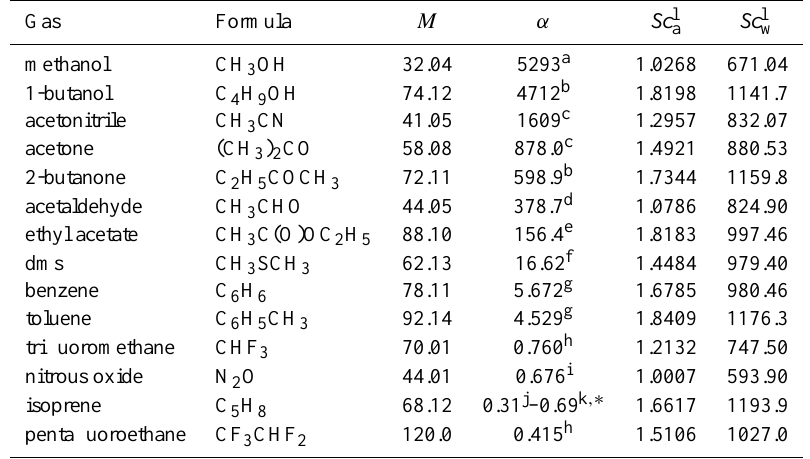
Table 1. Molecular masses ( M in gmol − 1 ), dimensionless solubility ( α ) and Schmidt numbers in air ( Sc a ) and water ( Sc w ) for the investi- gated tracers at 20 ◦ C.